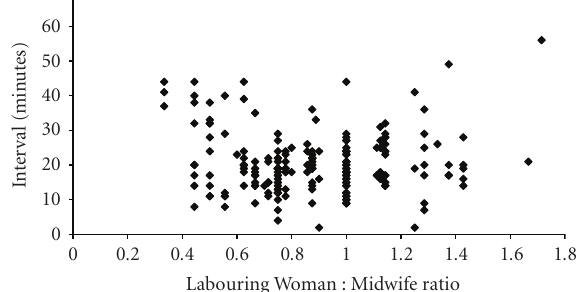
Figure 10: Preoperative time in theatre versus Labouring Woman: Midwife ratio (grade